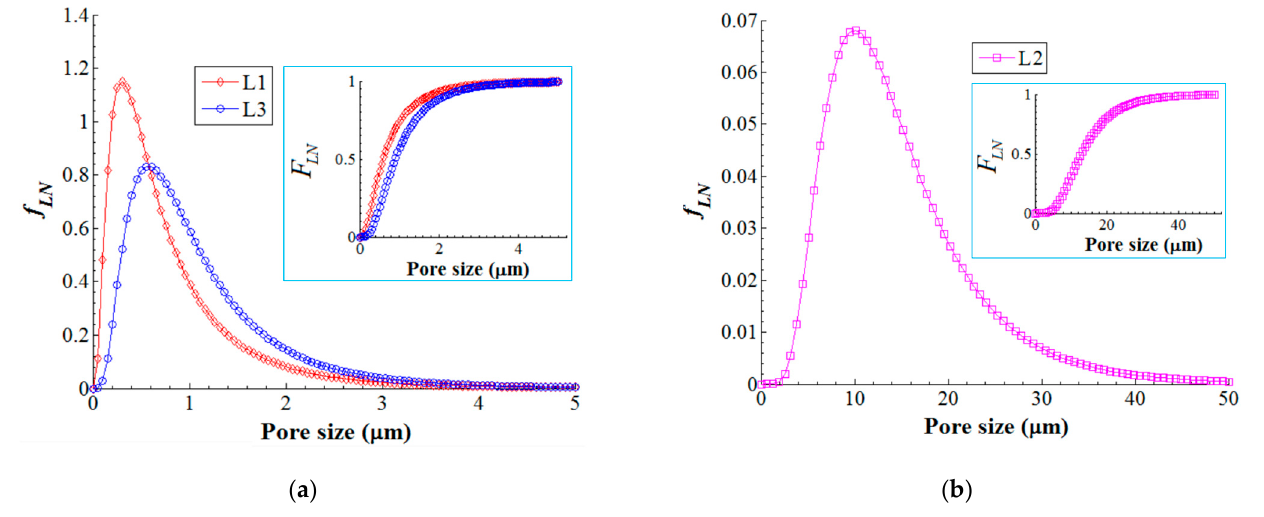
Figure 10. Lognormal probability density function ( f LN ) of the pore size distribution for composite membrane (PVDF-HFP/HS): ( a ) pore size distribution in layers L1 and L3; ( b ) pore size distribution in layer L2; inset images—cumulative distribution function ( F LN ).